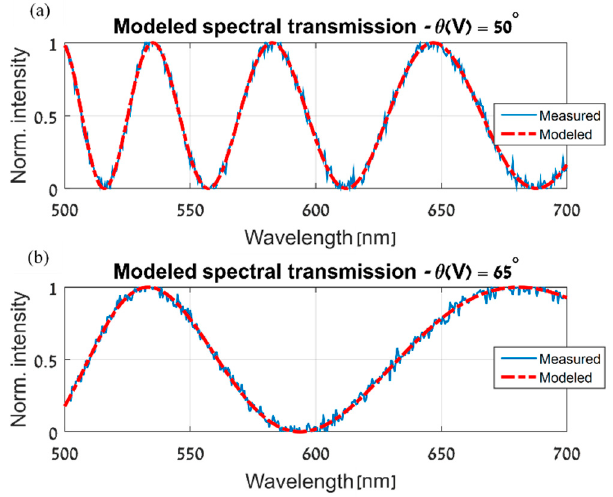
Figure 6. The parametric model as estimated at the chosen base location, ( x 0 , y 0 ) , at two di ff erent molecular tilt angles, ( a ) 50 ° and ( b ) 65 ° .